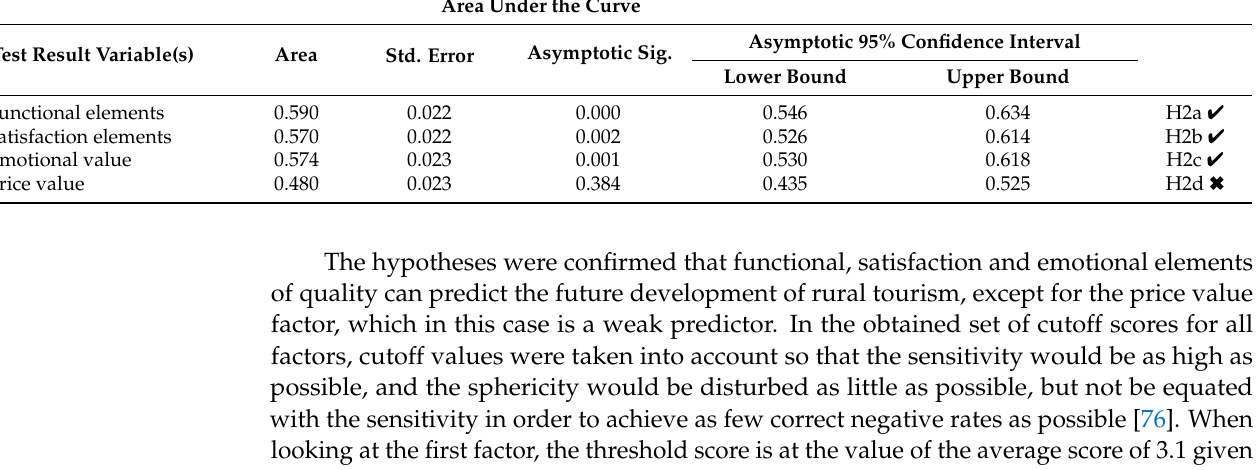
Table 4. AUC results. Area Under the Curve